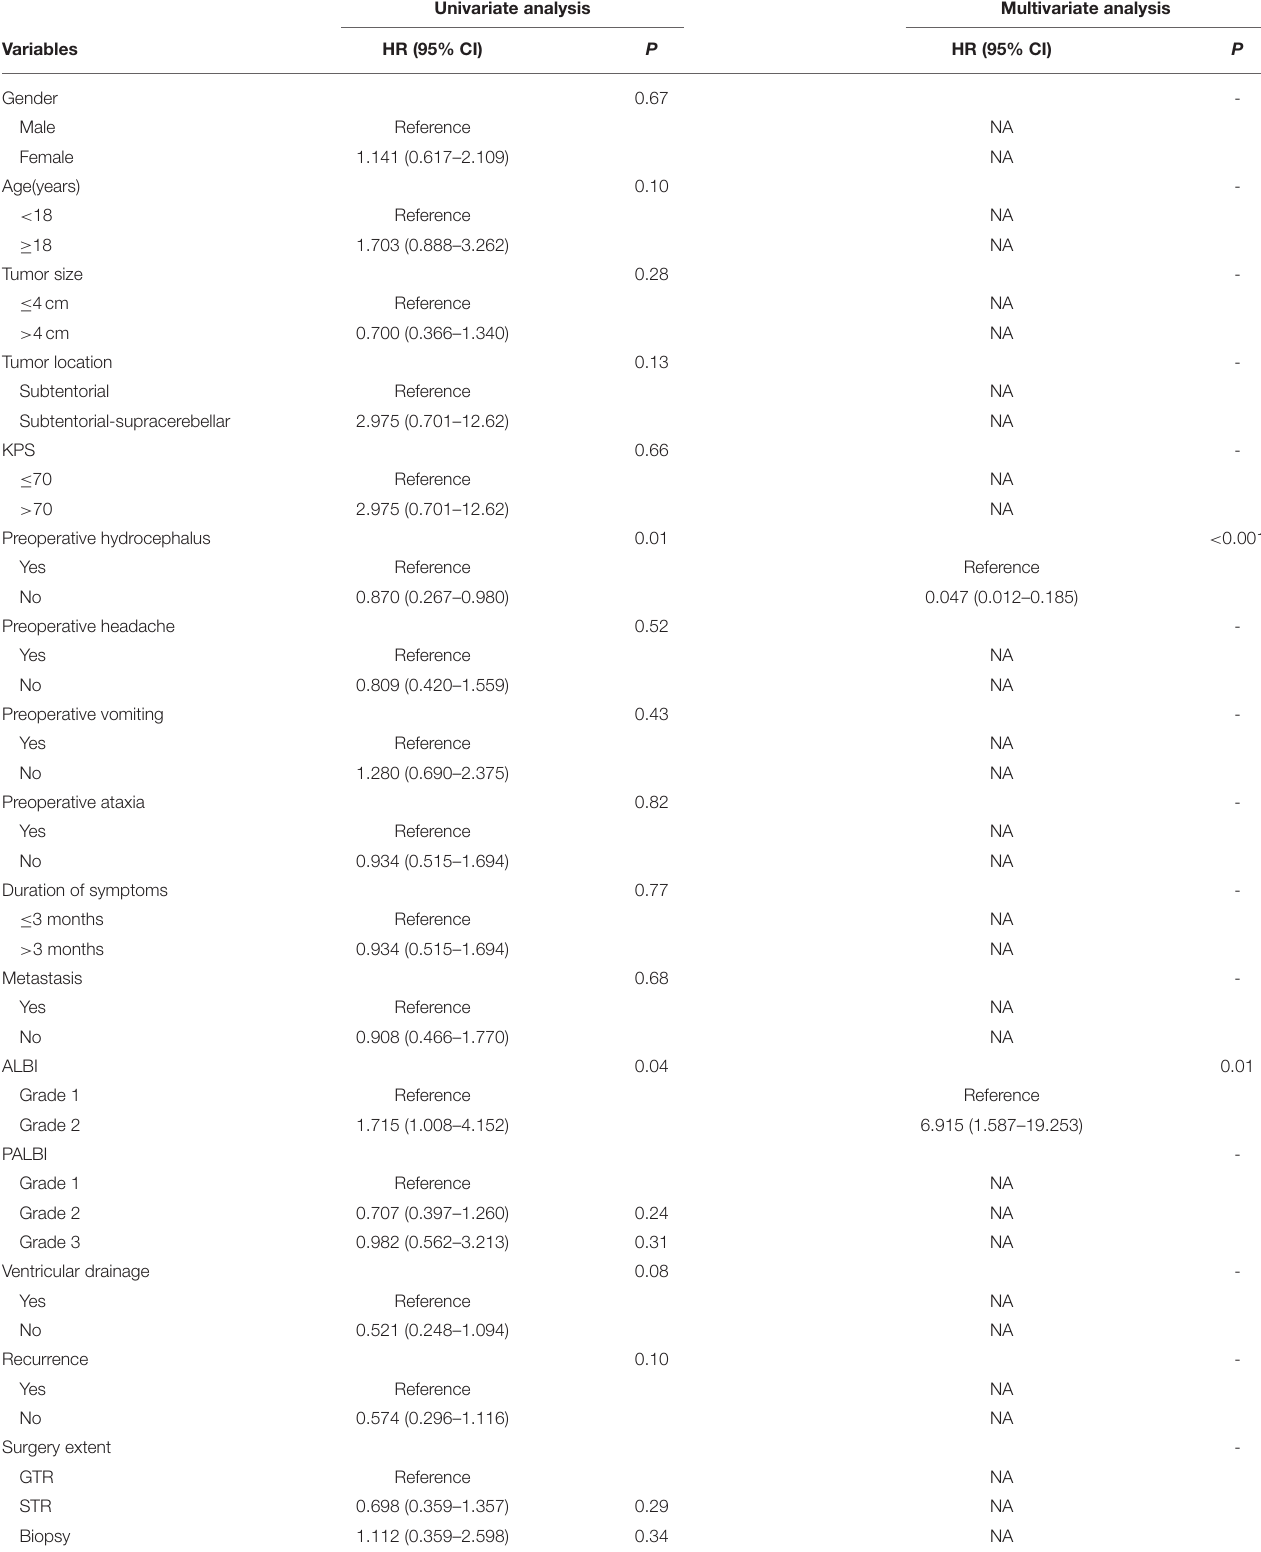
TABLE 3 | The univariate and multivariate analyses of overall survival in patients with medulloblastoma. Univariate analysis Multivariate